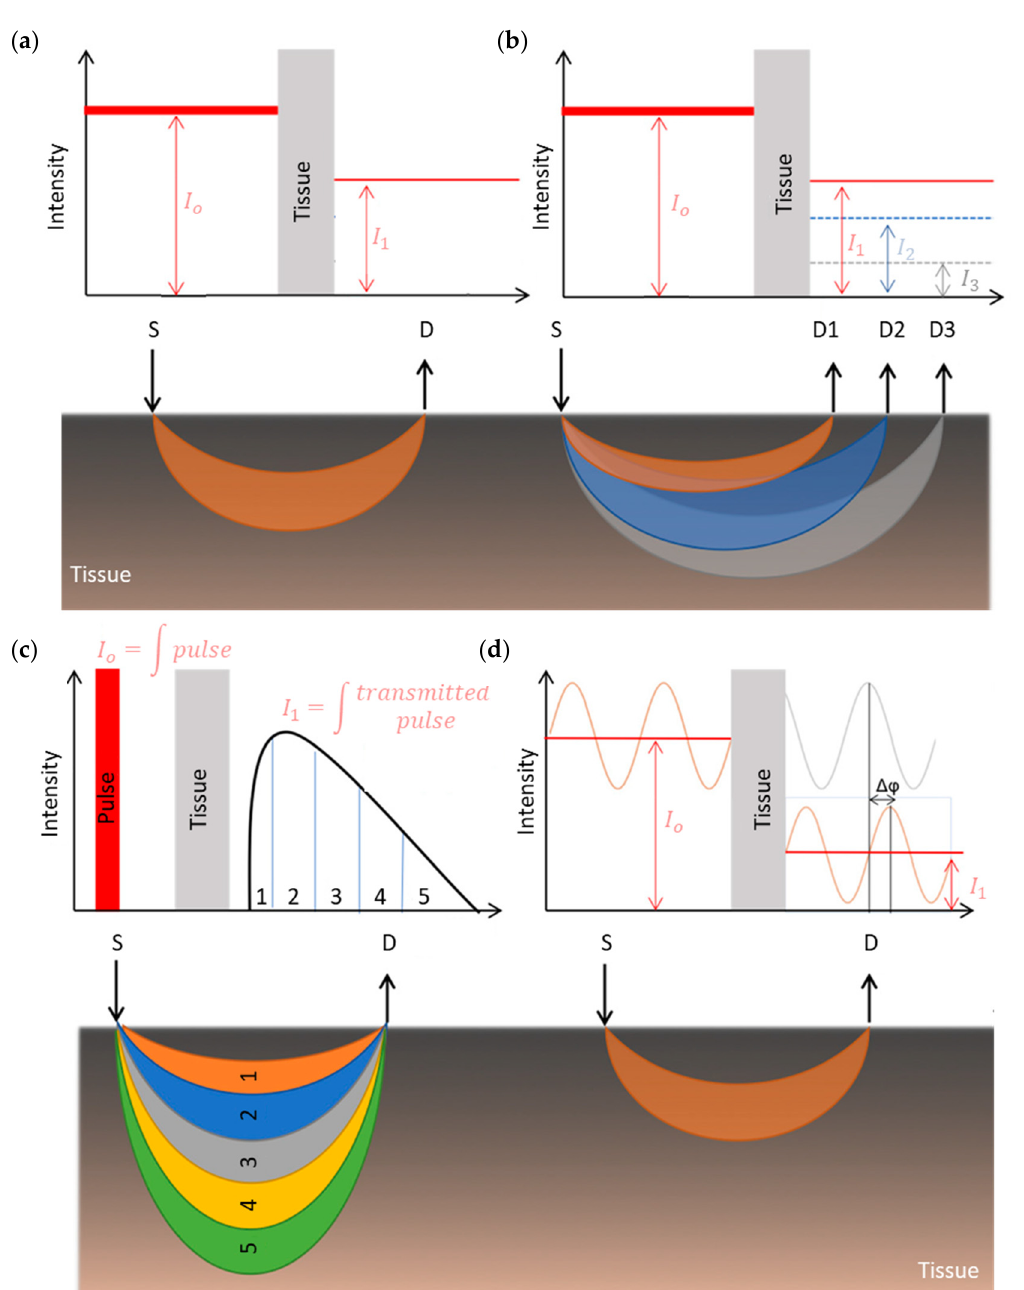
Figure 6. Schematic diagram of NIRS detection modes. ( a ) Continuous wave NIRS (CW-NIRS), ( b ) spatially resolved spectroscopy (SRS), ( c ) time-resolved spectroscopy (TD-NIRS), and ( d ) phase modulated spectroscopy (PMS). The figure also shows a representation of the photon path in tissues for each technique. S: source, D: detector. (Figure modified from